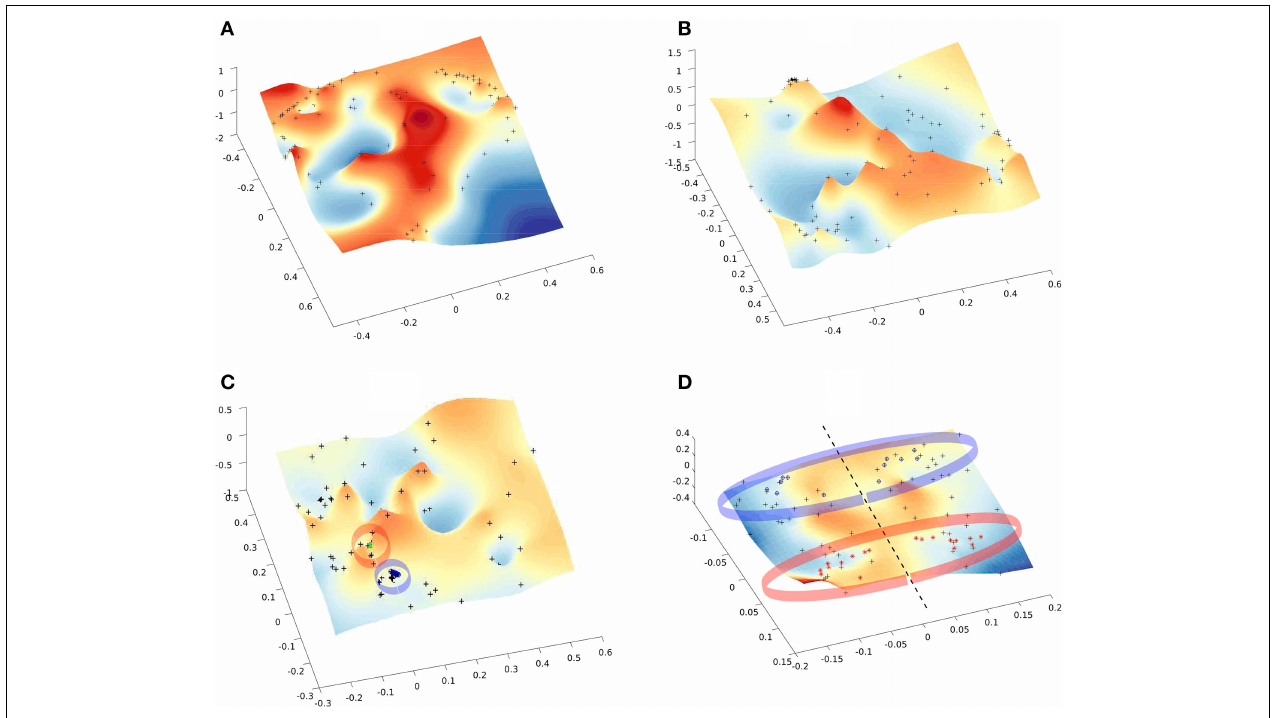
embedded network (D) DTI embedded network. Black dots indicate the embedded nodes. In plots (C,D) , blue and red points indicate the groups of brain areas discussed in the text.